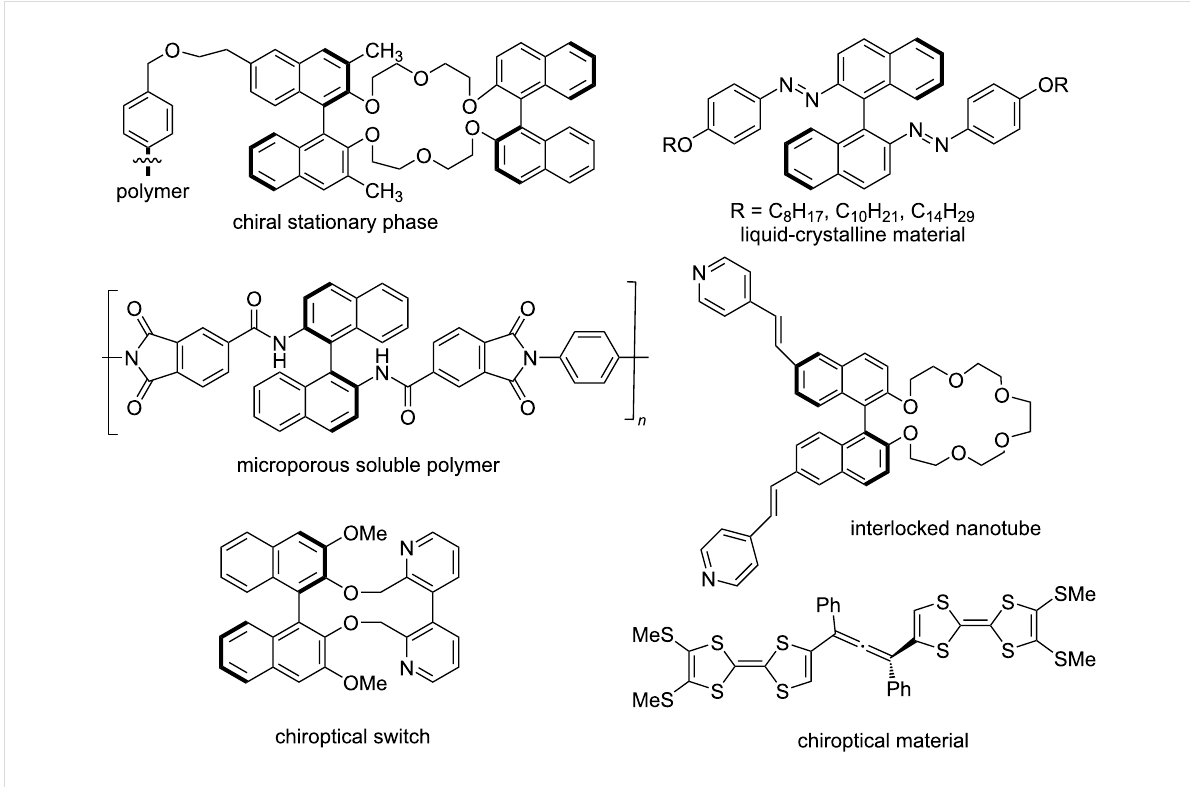
Figure 3: Axially chiral functional materials and supramolecules.